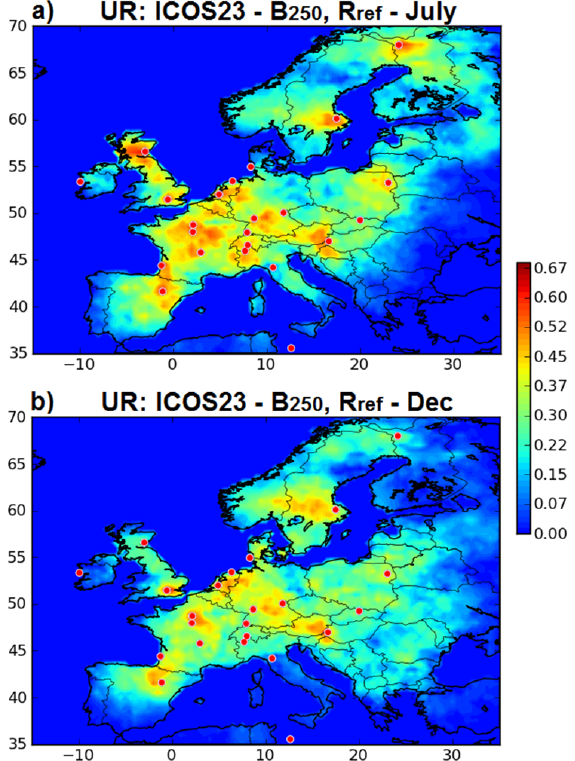
Figure 2. Uncertainty reduction (theoretically comprised between 0 and 1) for a 2-week-mean NEE at 0.5 ◦ resolution in July (a) and in December (b) when using ICOS23 (red dots) and the reference inversion setup. Red/blue colors indicate relatively high/low uncer- tainty reduction (with min = 0 and max = 0.68 in the color scale).